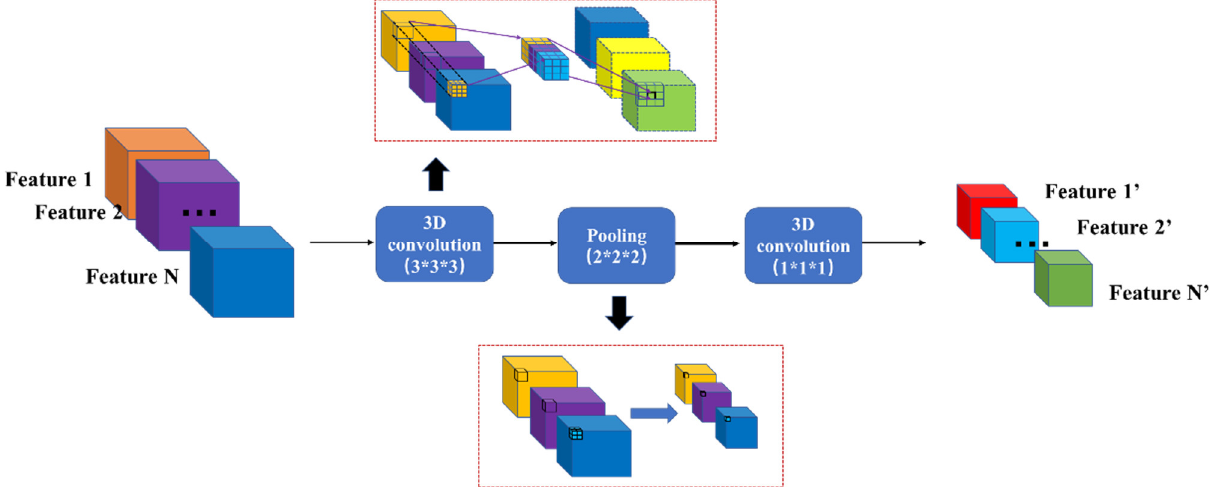
Figure 3. The structure of the Extractor module.